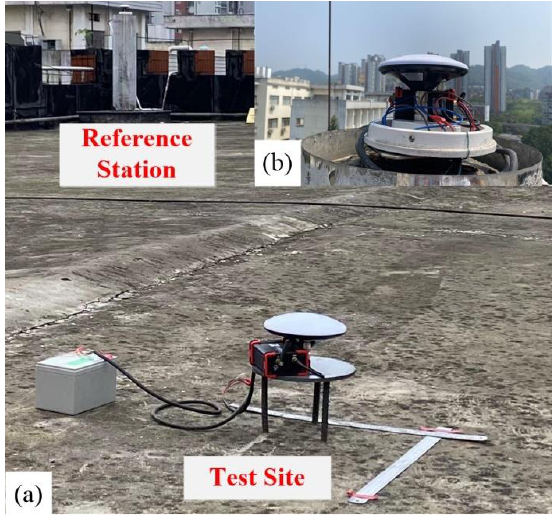
Figure 14. Experimental apparatus used for dynamic experiment evaluation. ( a ) Photo of overall dynamic scenario; ( b ) enlarged details of reference station.